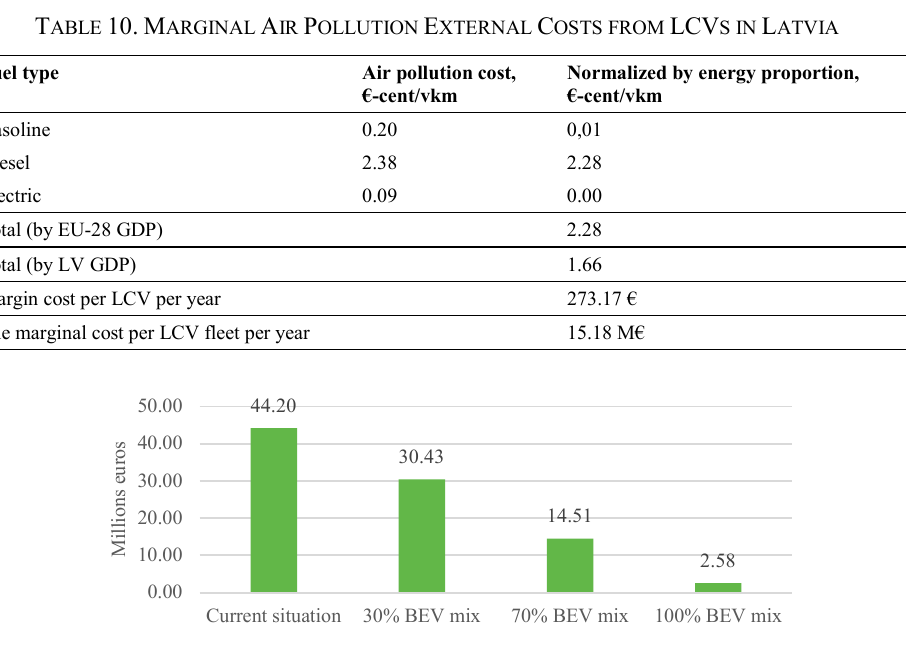
Fig. 1. Yearly air pollution external costs with different BEV proportions in Latvia’s passenger car and LCV